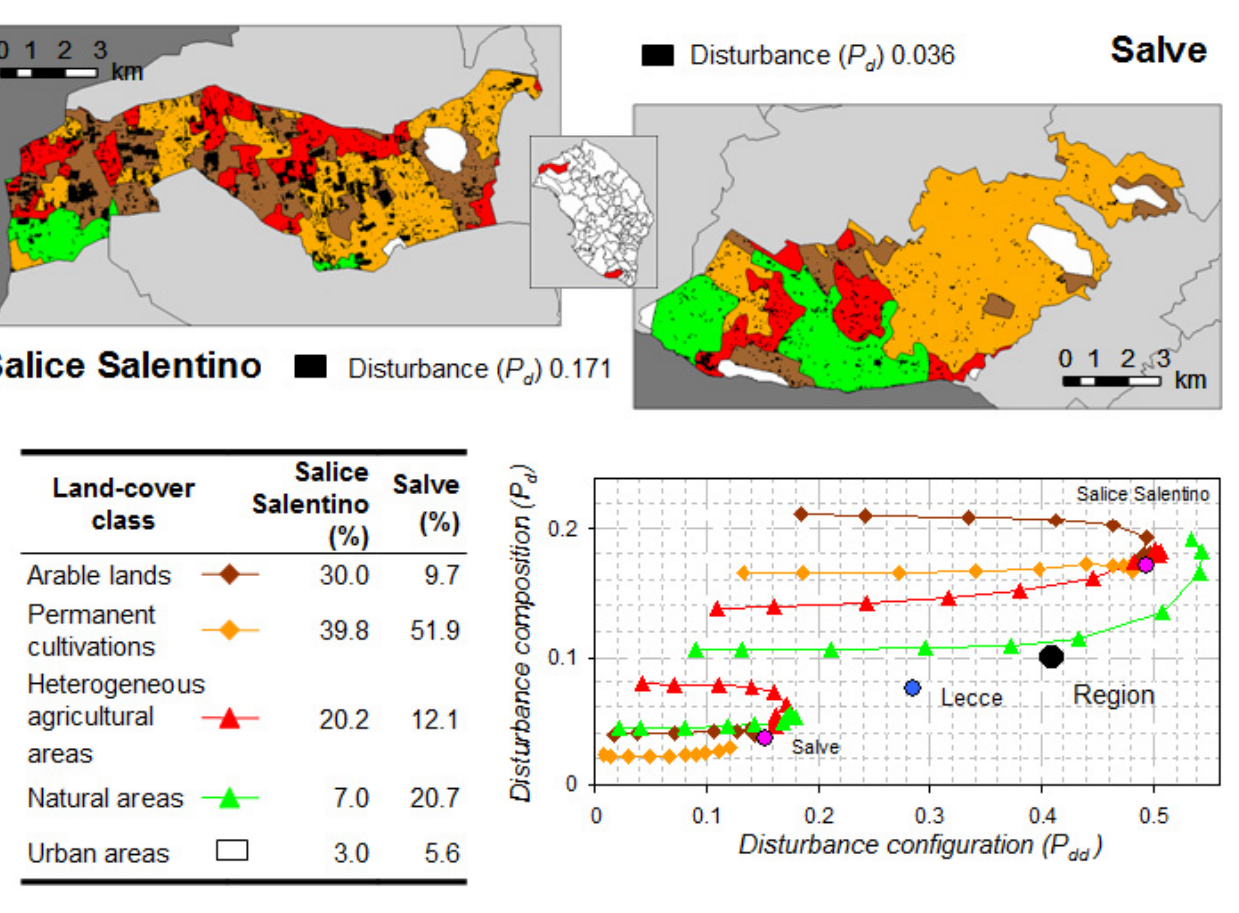
Fig. 5. Land-use disturbance trajectories at multiple scales (10 window sizes) for two counties (second nested jurisdictional level) of Apulia at regional P = 0.10, i.e., Salice Salentino and Salve in the d province of Lecce (small map in the center). On top, maps of land use with disturbed locations in black. Land-use percentage composition (bottom left), and disturbance trajectories for land-uses (bottom right) in the same state space [P , P ] of Figg. 2, 3, and 4, with the pertinent CPs and the CPs of the upper d dd hierarchical levels of the panarchy, i.e., Lecce province and region (see